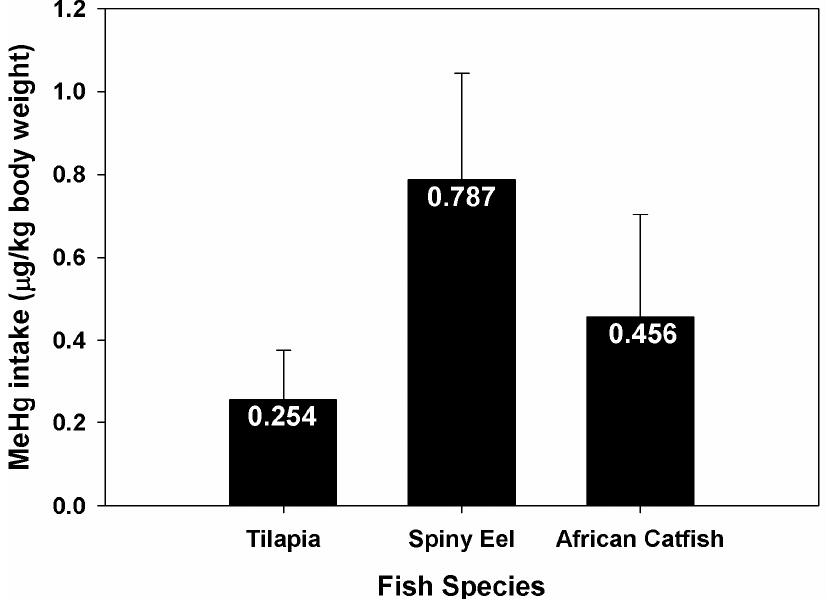
Figure 3. Intake of MeHg by consuming one kg of fish from Lake Phewa by a 60 kg person. The figures indicate average value and the error bars indicate standard